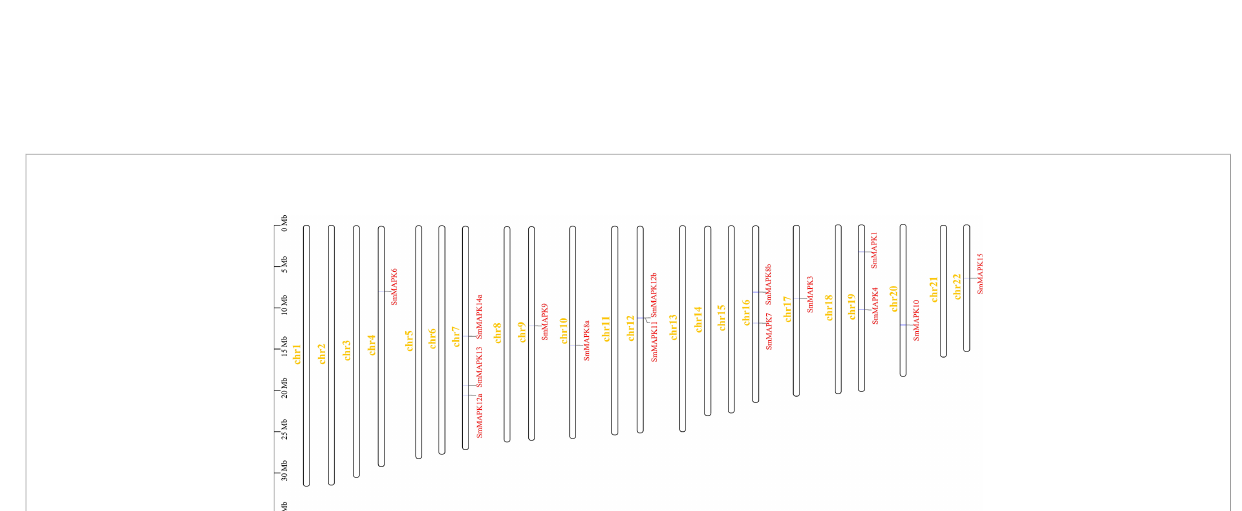
FIGURE 2 Chromosomal distribution of Scophthalmus maximus mitogen-activated protein kinase (MAPK) genes. The MAPK genes and chromosomes are highlighted in red and yellow, respectively.